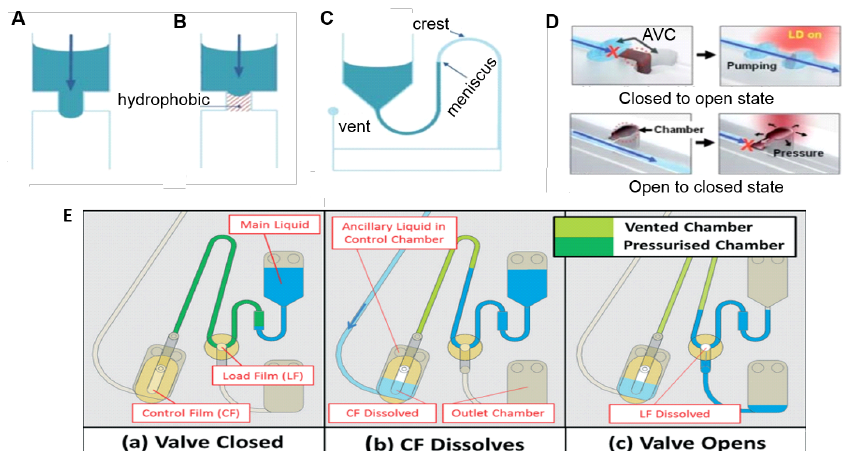
Figure 3. Centrifugal microfluidics valving methods: ( A ) capillary valve on a hydrophilic microchannel; ( B ) hydrophobic and ( C ) siphon valves. Adapted from [36] with permission from The Royal Society of Chemistry. ( D ) Laser irradiated ferrowax microvalves: at the top, from a closed to open state, the laser beam is focused at the ferrowax that melts and flows to an assistant valve chamber (AVC); at the bottom, to block an open channel, the laser is focused at the pre-loaded ferrowax located adjacent to the main channel. The molten ferrowax bursts into the main channel and solidifies, blocking it. Adapted from [49] with permission from The Royal Society of Chemistry; and ( E ) event-triggered valve based on dissolvable film (DF): ( a ) sample is loaded and the two DF tabs create a closed pneumatic chamber. The counteracting gas pressure keeps preventing the liquid to enter the pneumatic chamber; ( b ) the ancillary liquid enters and dissolves the control film (CF) and the pneumatic chamber is vented, allowing the main liquid to wet the load film (LF), and ( c ) sending liquid to the outlet chamber. Reproduced from [42] with permission from The Royal Society of